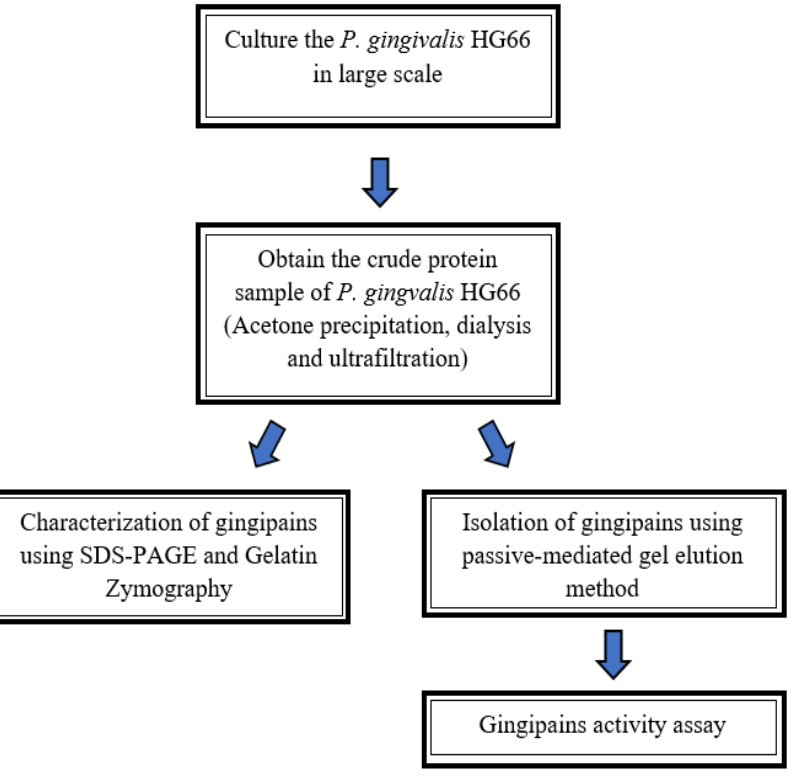
Figure 1. An overview of the studies performed to isolate and characterize the gingipains is shown in the fl owchart above.